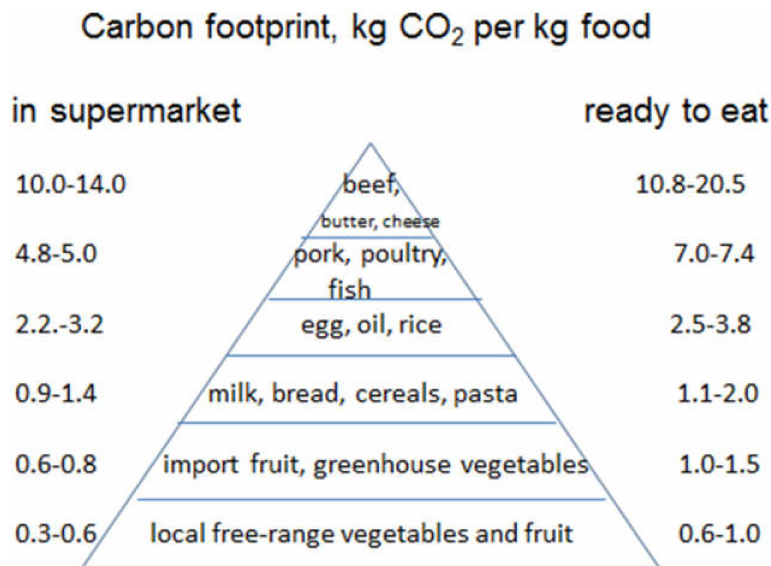
Figure 1. Carbon footprint (kg CO 2 eq) of di ff erent food groups per kg food in the supermarket and